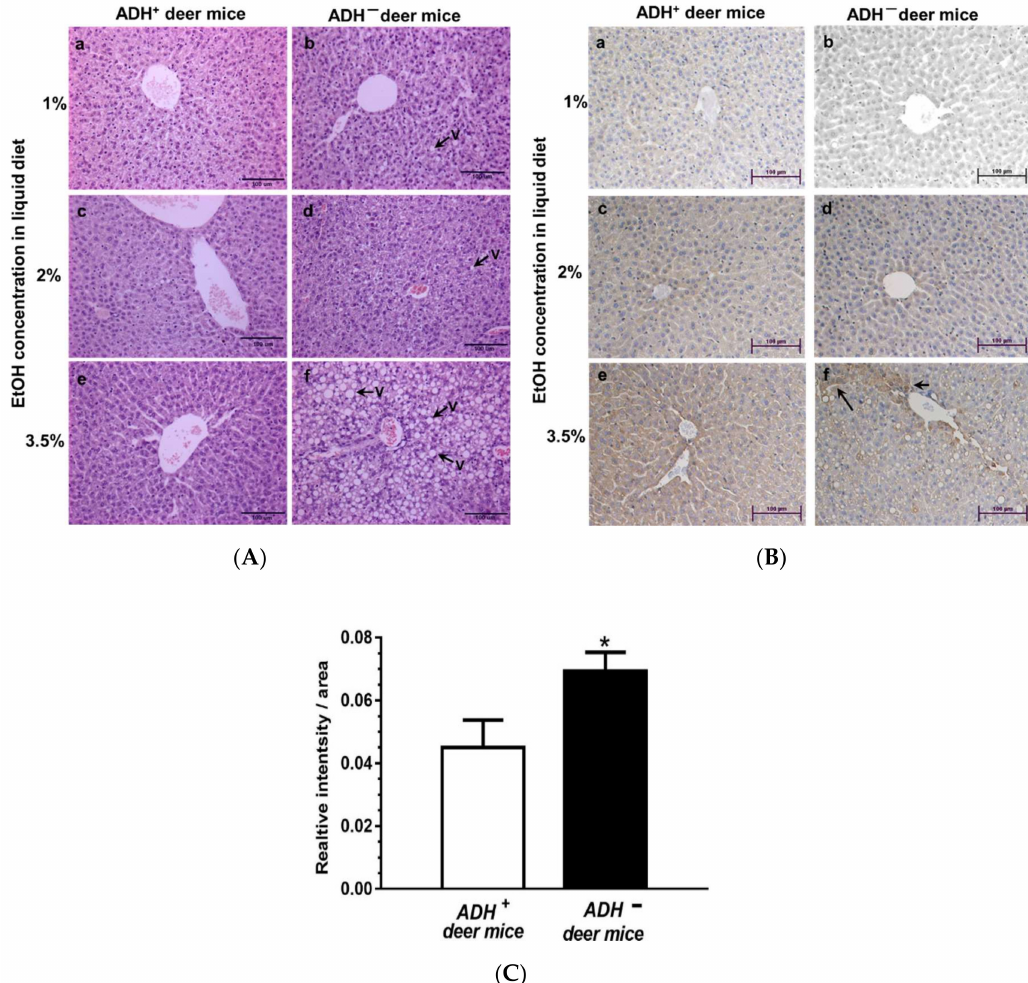
Figure 1. H&E ( A ) and GRP 78 immunohistochemical (IHC) ( B ) staining of representative liver tissue sections from 1%, 2% or 3.5 % EtOH-fed ADH + ( a , c , e ) and ADH − ( b , d , f ), respectively, fed daily for 2 months. Dose-dependent hepatic steatosis (fat vacuolization) with significant ER stress (GRP78) was distinctly observed in the liver sections of ADH − deer mice fed 3.5% EtOH (original magnification × 20). The pair-fed controls of both strains showed normal histology and no positive staining for GRP78 antibodies. Quantification of the intensity of immunohistochemical staining for GRP78 ( C ) in the livers of ADH + versus ADH − deer mice fed 3.5% EtOH for 2 months. Data are presented as means ± standard errors of means (SEMs) ( n = 5); * p <